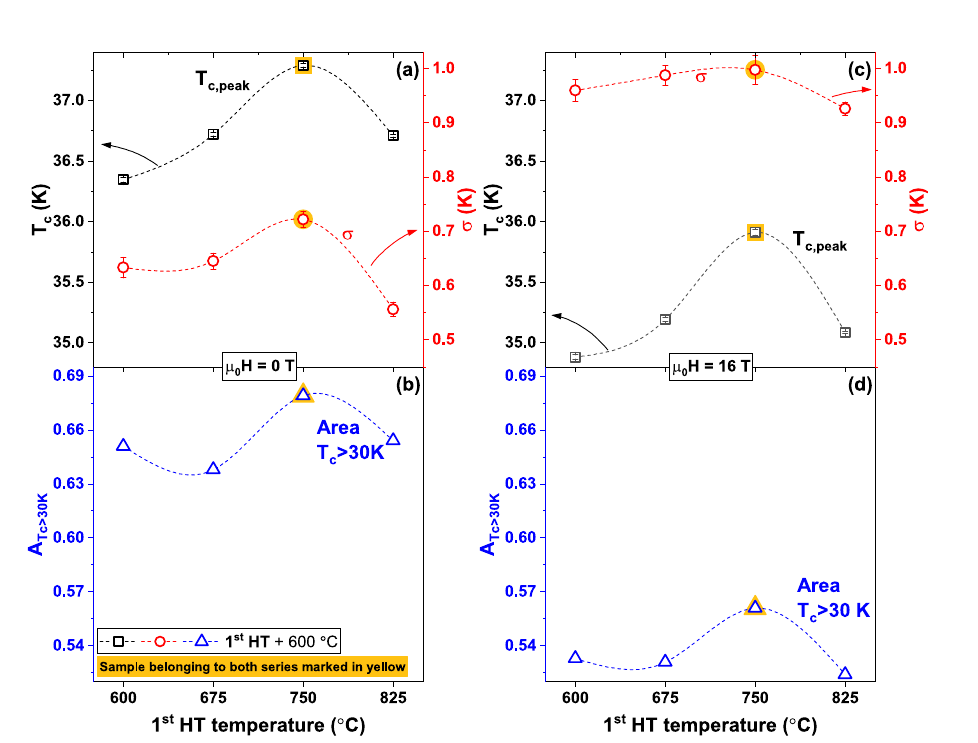
Figure 3. T c -distribution properties of the K-Ba122 samples as a function of the 1st HT temperature. ( a ) position and width of the main peaks in the T c -distributions at 0 T obtained in Fig. 2. ( b ) area of the 0 T T c - distribution above 30 K. ( c , d ) similar data for the 16 T